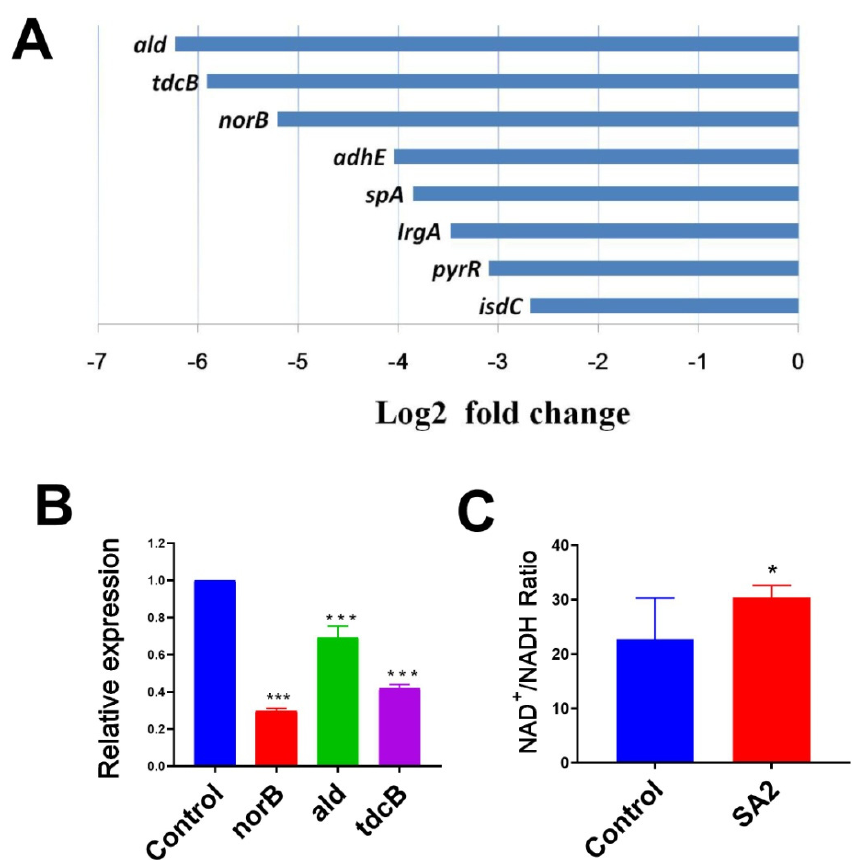
Figure 8. Profile of downregulated genes and NAD + /NADH ratio after SA2 treatment. The most significant log2fold changed gene in the transcriptomic profile ( A ). The expression of the norB , ald, and tdcB genes after SA2 treatment was measured by RT-PCR, *** p < 0.001 vs. model group, n = 3 ( B ). NAD + /NADH ratio was measured after SA2 treatment, * p < 0.05 vs. control group, n = 3 ( C ).